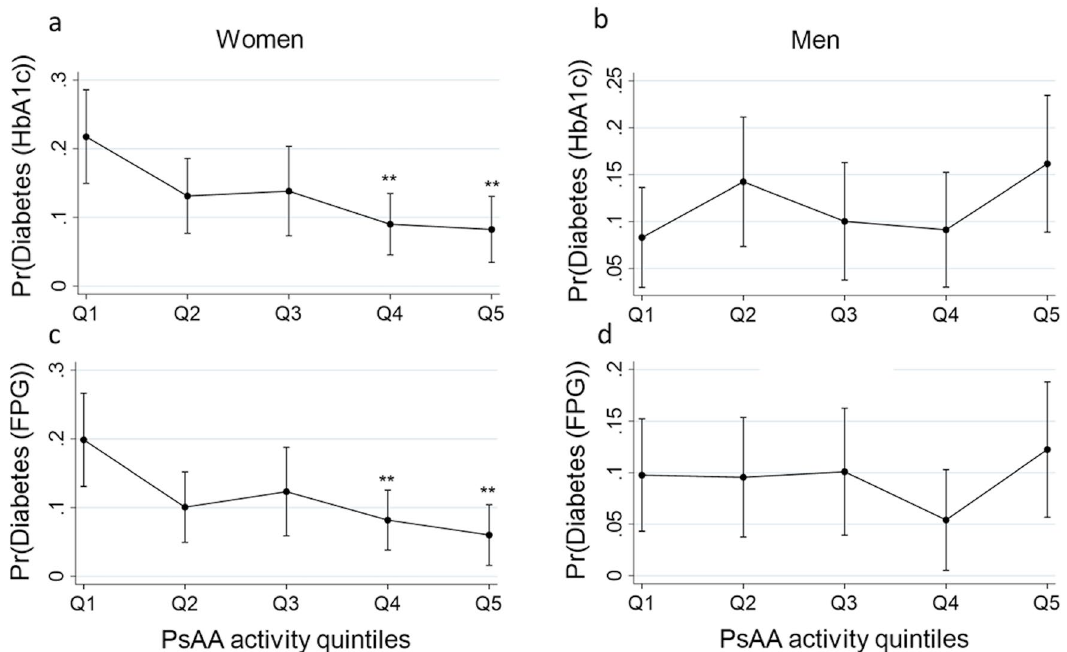
Figure 2. Predicted probabilities for having diabetes across pSAA activity quintiles by gender. Diabetes is defined with HbA 1c ( c,d ) or FPG ( a,c ). **Indicate significant difference (1% level) relative to Q1. The bars represent 95% confidence